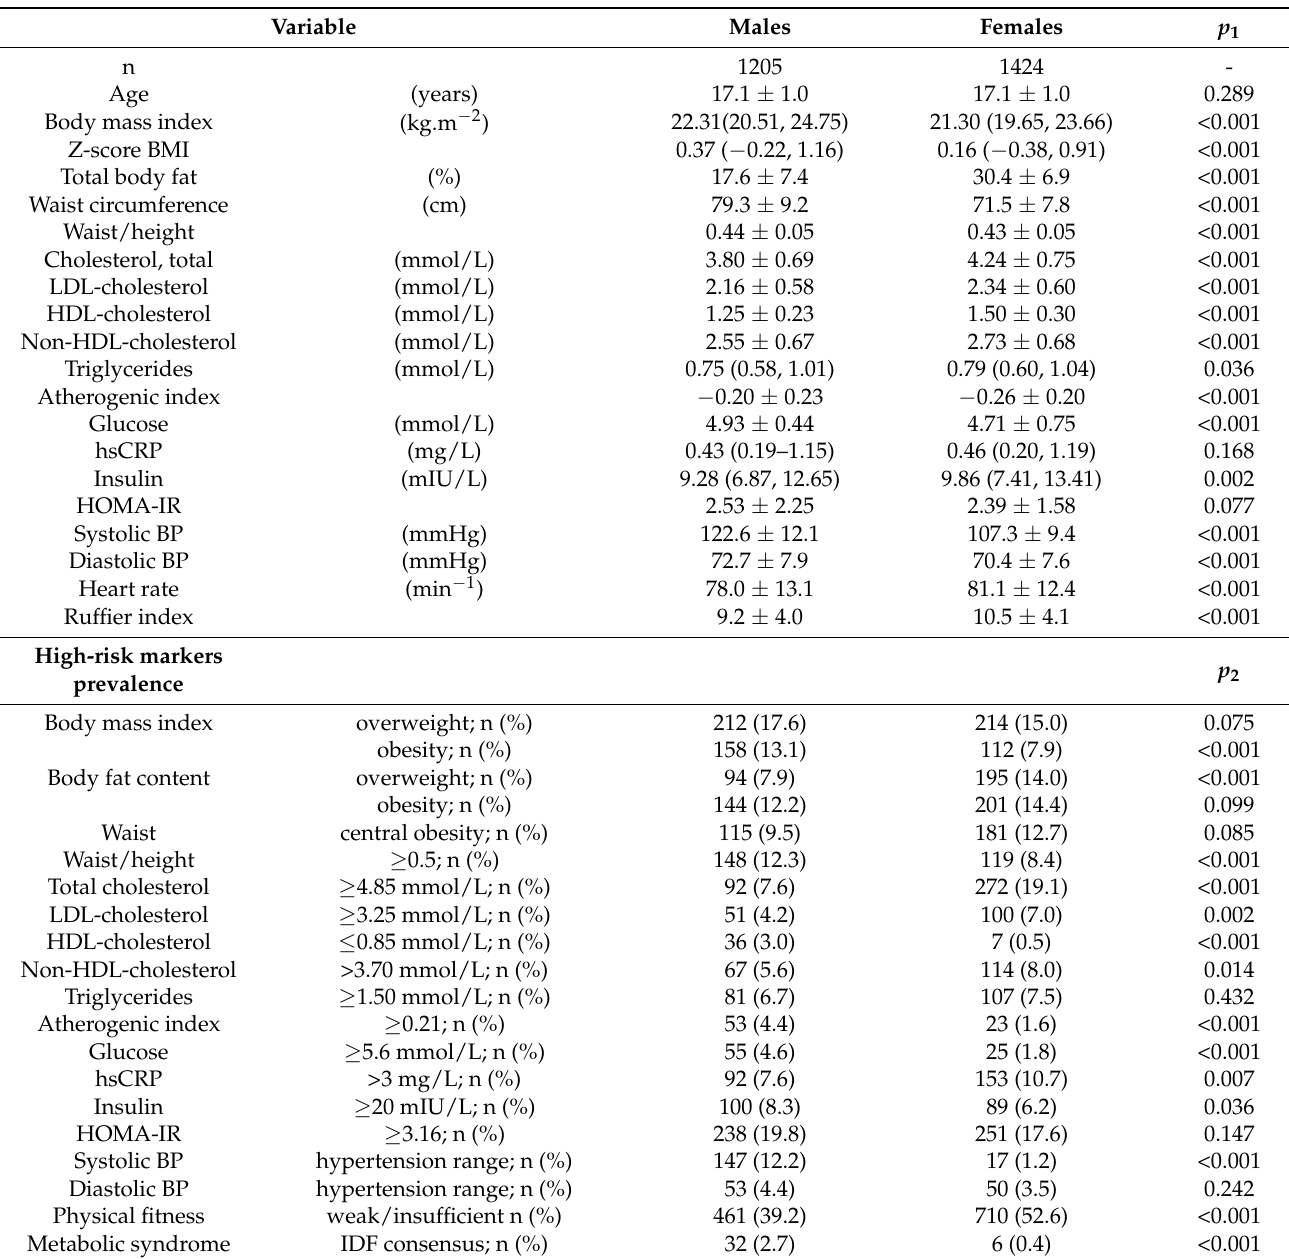
Table 1. Basic sample characteristics and sex differences (n =